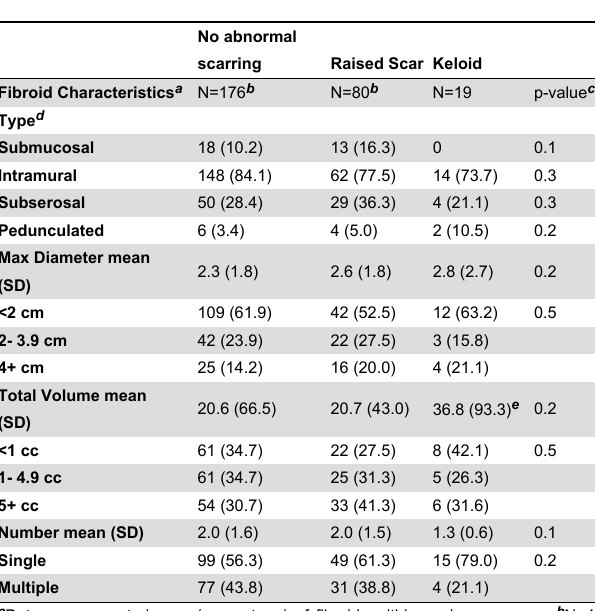
Table 3. Characteristics of Prevalent Fibroids by Self- Reported Scar